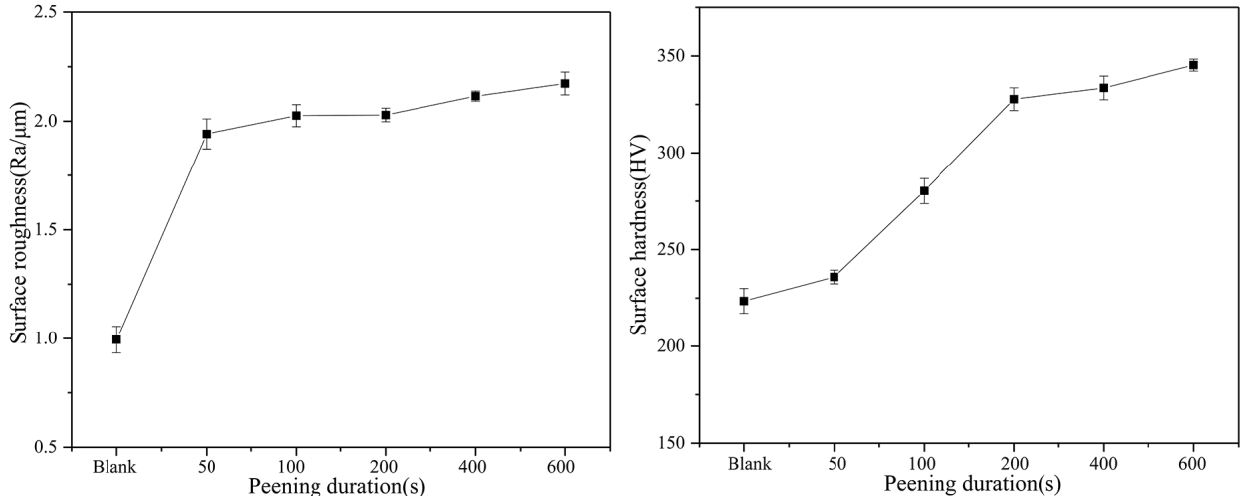
Figure 7. Surface roughness and microhardness evolutions of the USPed samples with different lengths of time.